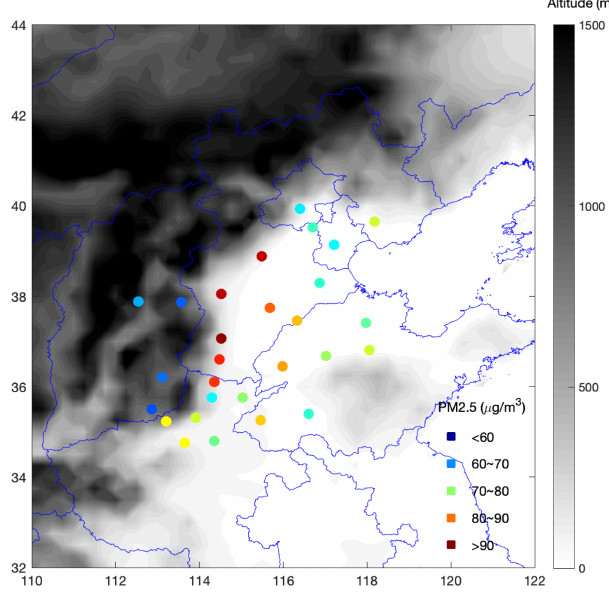
Figure 1. Distribution of annual mean PM 2 . 5 concentrations in the 28 cities by altitude. The PM 2 . 5 concentration is the annual mean value from 2014 to 2019 (units: µgm − 3 ). The elevation over the domain was obtained from a global digital elevation model with a resolution of 0 . 5 ◦ × 0 . 5 ◦